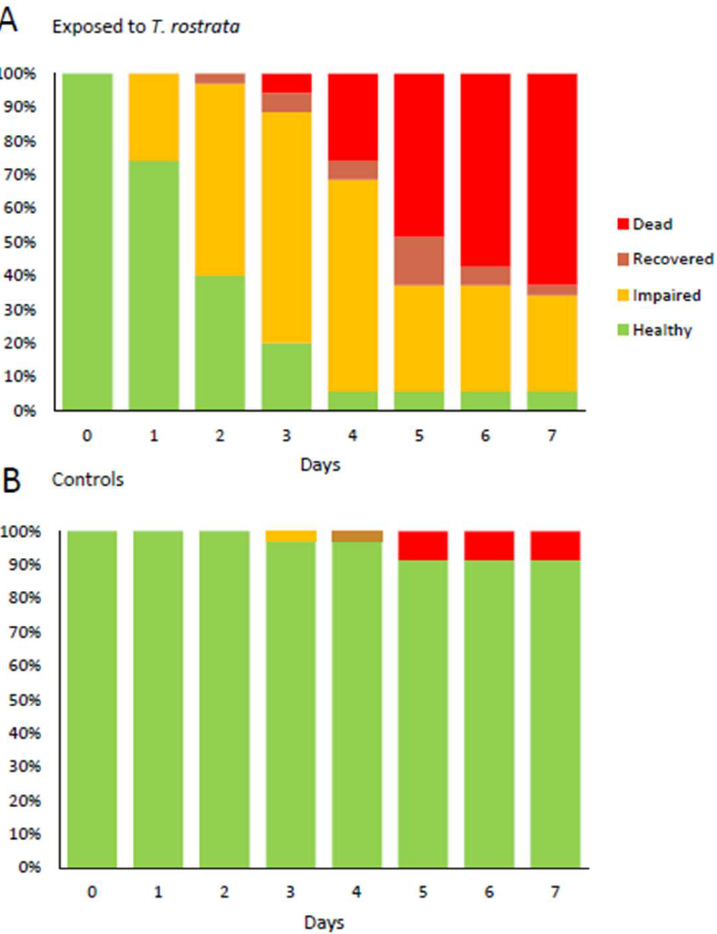
Figure 7. Health status of D. reticulatum over 7 days ( A ) after exposure to T. rostrata theronts and ( B ) without exposure to T. rostrata. Slugs were assessed as “impaired” if they displayed reduced ability to extend the superior tentacles and as “recovered” if they displayed normal tentacle movement on days after being assessed as impaired.